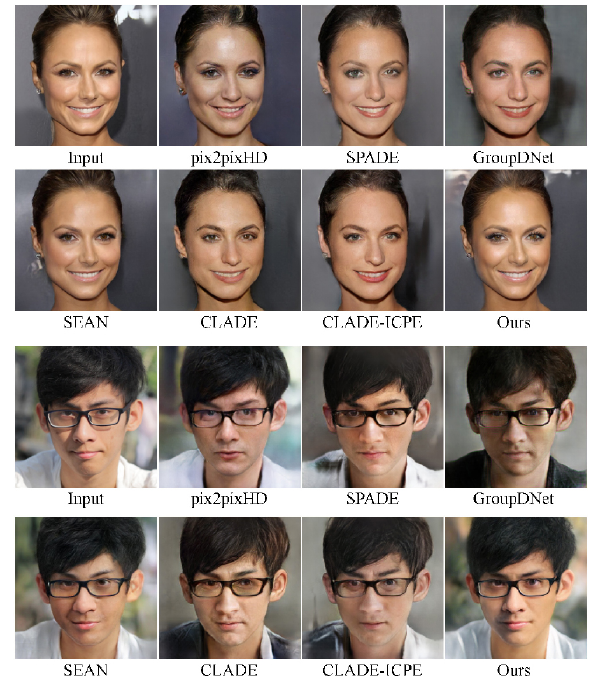
Fig. 6 Image reconstruction